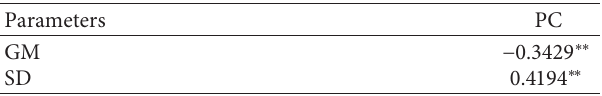
Table 2: Linear regressions and model fit parameters for statis- tically correlated ( p < 0 . 05) parameters and duration of storage on paddy crackness.